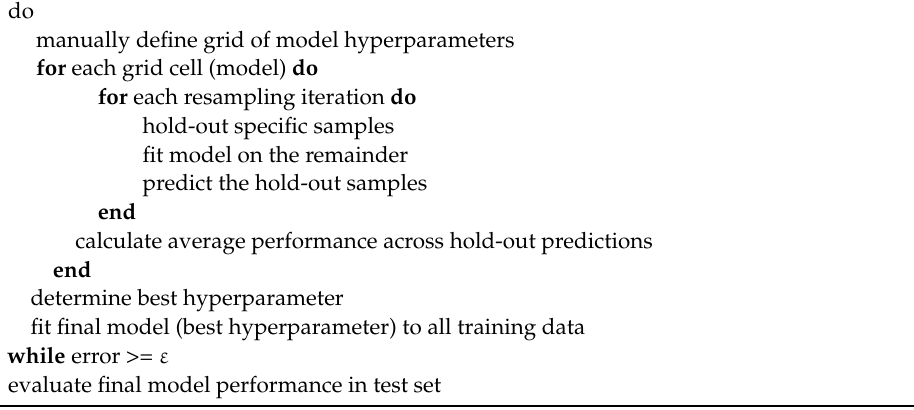
Algorithm 1 : Pseudocode for the iterative grid-based training process algorithm.